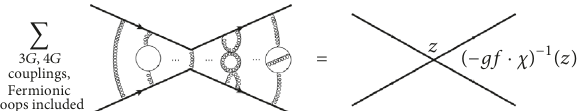
Figure 1: Effective Locality pictured in a rather symbolic way in which the sum of all possible QCD interactions between 2 scattering quarks “boils down” to a local contact-type interaction mediated by the structure (−𝑔𝑓 ⋅ 𝜒) −1 (𝑧)